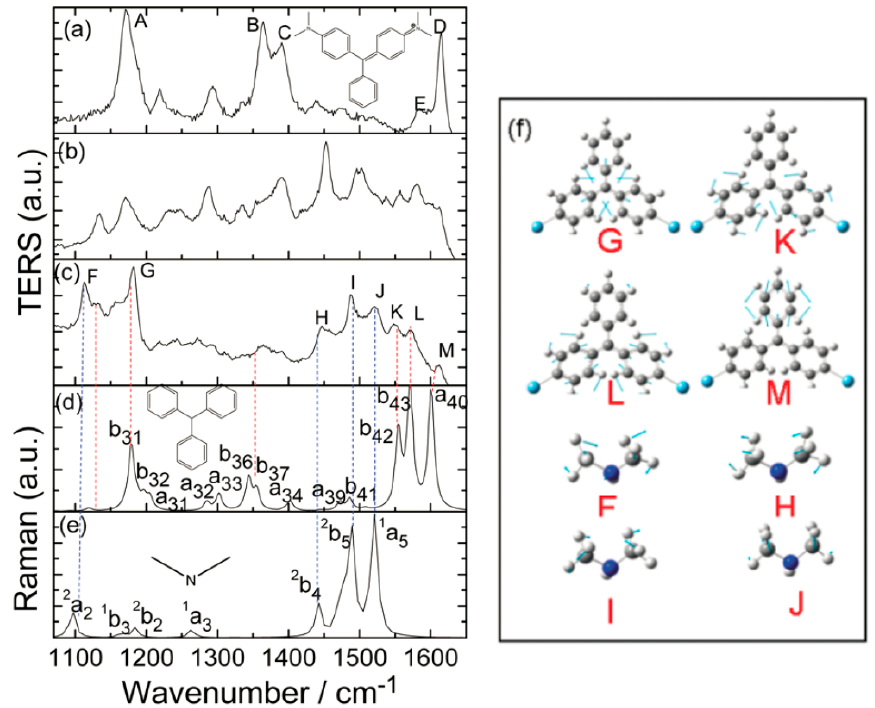
Figure 4. Time sequential tip-enhanced resonance Raman spectroscopy (TERRS) and the vibrational modes of MG. ( a ) The initial, ( b ) intermediate (20 min after continuous radiation using a laser), and ( c ) the final spectra (40 min after continuous radiation using a laser). The tunneling current and the bias voltage are 1 nA and 1 V, respectively. ( d ) and ( e ) Simulated Raman spectra of fragments (see the insets). ( f ) The vibrational modes of dissociated fragments of MG (corresponding to the experimental peaks in ( d ) and ( e ), as calculated by density functional theory). Adapted from [9].